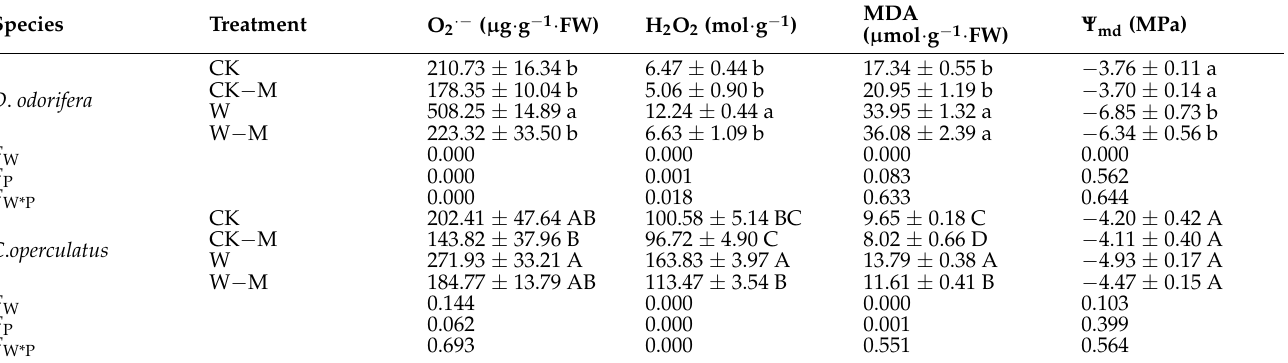
Figure 5. Comparative analyses of the concentrations of soluble sugar ( a ) and starch ( b ), and primary root activity ( c ) of C. operculatus and D. odorifera under all treatments. Abbreviations, explanations of treatments, data descriptions, and statistics are the same as those shown in Figure 1. Table 3. Comparative analyses of the levels of O 2 ·− , H 2 O 2 , MDA, and Ψ md of C . operculatus and D . odorifera under all